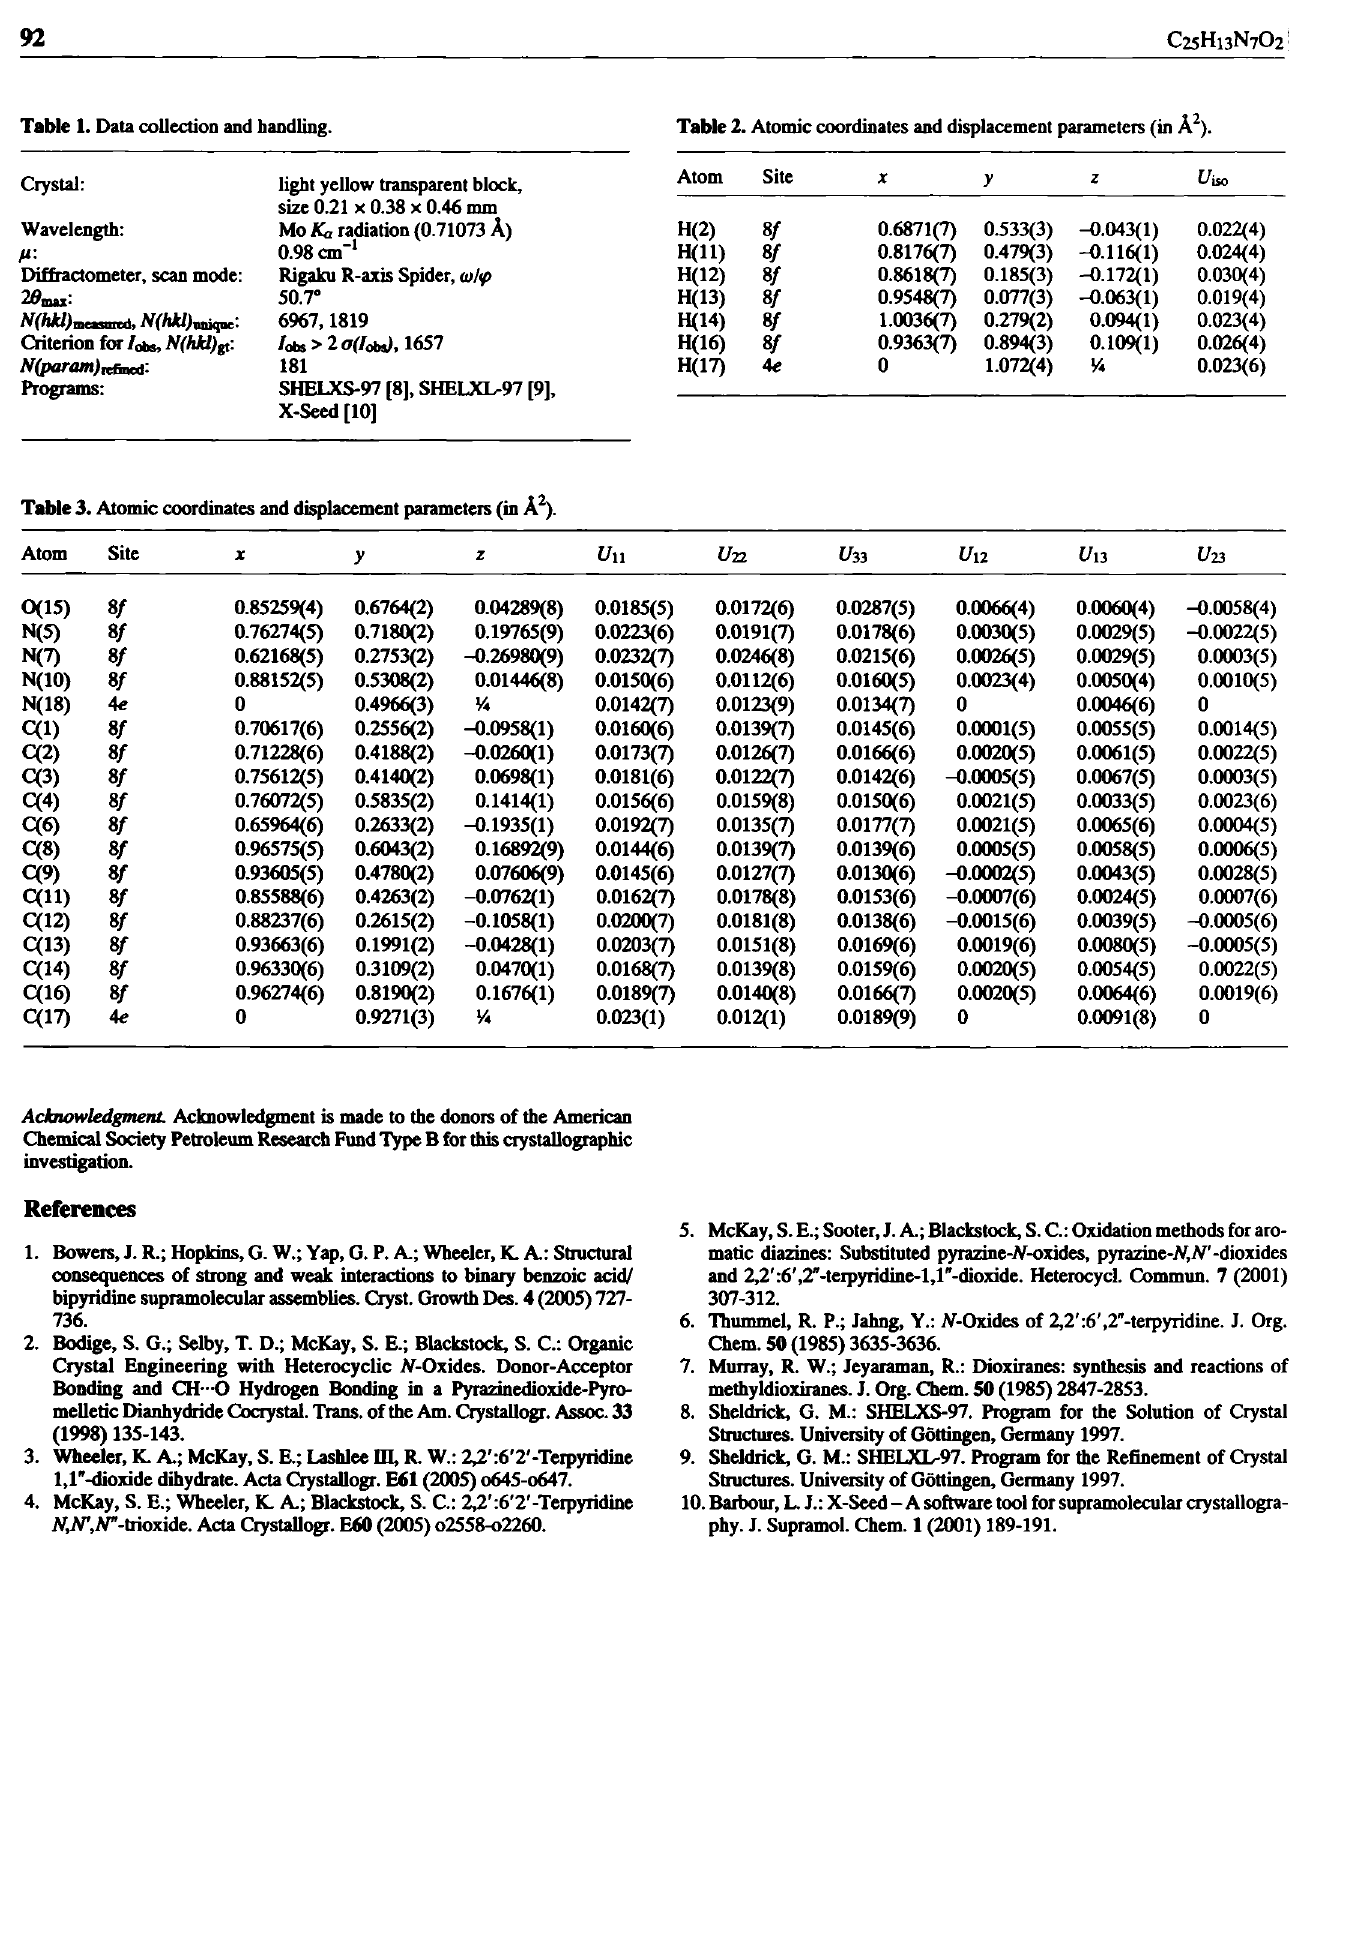
Table 1. Data collection and handling. Table 2. Atomic coordinates and displacement parameters (in A 2 ).